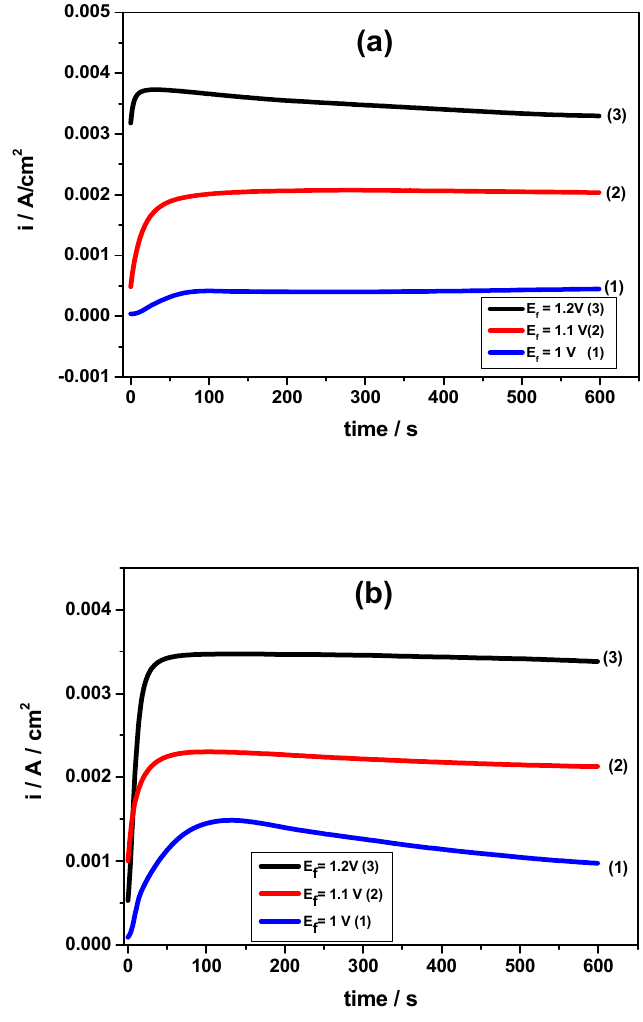
Figure 3. Current–time plots recorded at different constant applied potentials for electrosynthesis of PPy from ILM-ACN electrolyte containing 0.5 M Py on IB ( a ) and ND ( b ) NiCr alloys. The curves can be divided in two periods: (1) an increased anodic current, corresponding to the onset of PPy electropolymerization and (2) a current stabilizing in time. The first part shows an